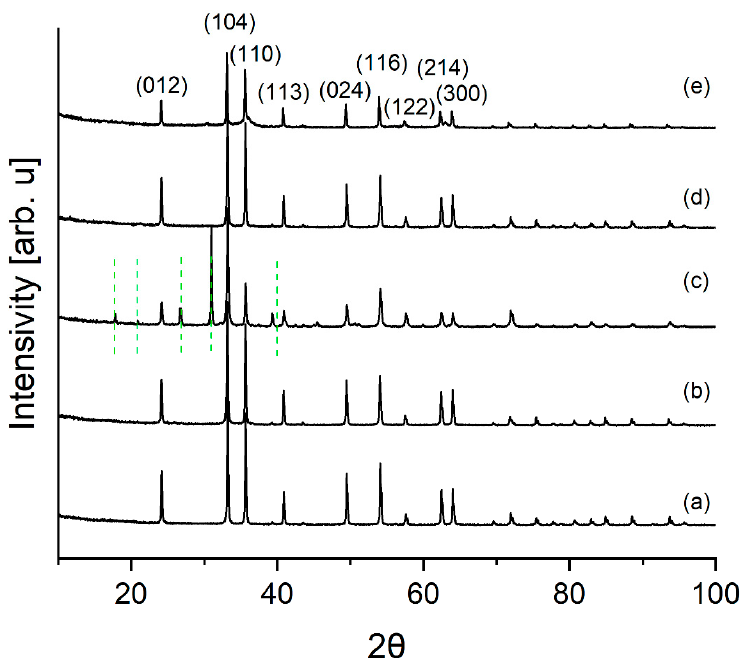
content of SiO 2 phase. Figure 4. XRPD pattern of iron pigment samples: ( a ) Commercial pigment A, ( b ) Commercial